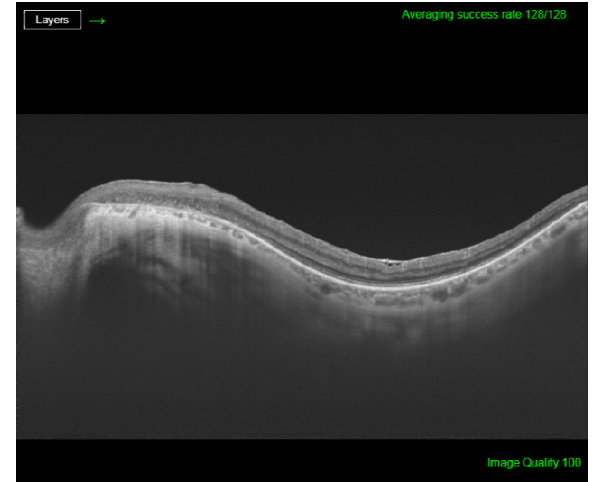
Figure 4: SS-OCT age of the left eye exhibits external retina damage with an increase in choroidal signal due to retinal pigment epithelium